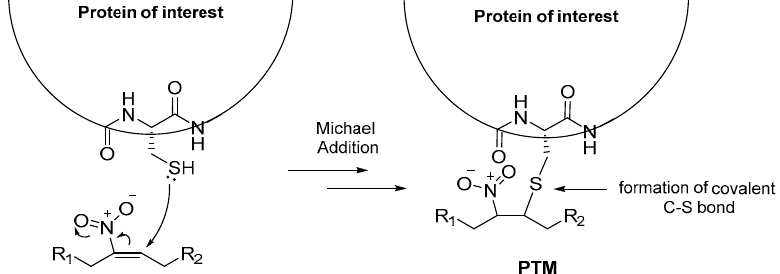
Figure 1. Post-translational modification of protein of interest by Michael addition [3].